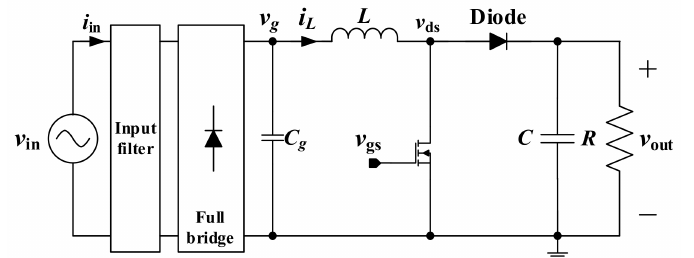
Figure 1. Boost PFC converter